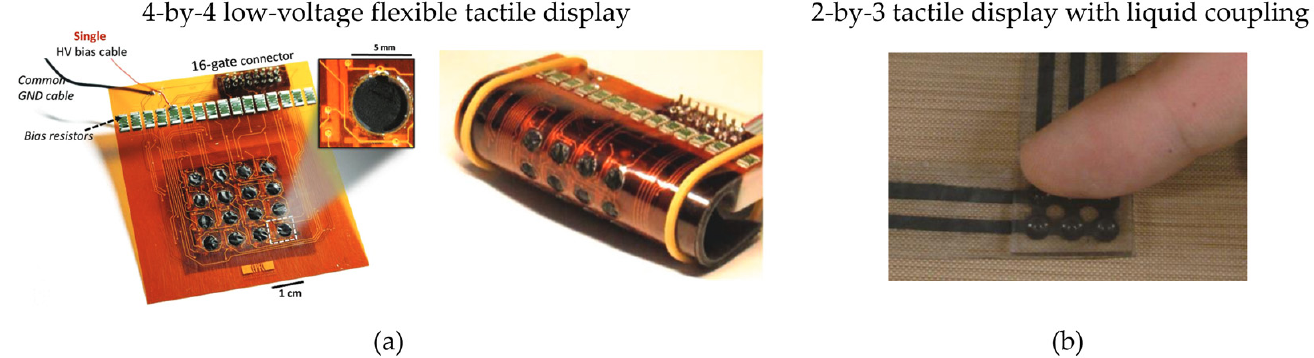
Figure 12. Examples of two ‐ dimensional DEA arrays for tactile displays: ( a ) 4 ‐ by ‐ 4 flexible array of low ‐ voltage actuators [111], reproduced with permission from John Wiley and Sons, copyright 2017; ( b ) 2 ‐ by ‐ 3 tactile display based on liquid coupling [150], reproduced with permission from Elsevier, copyright 2014.